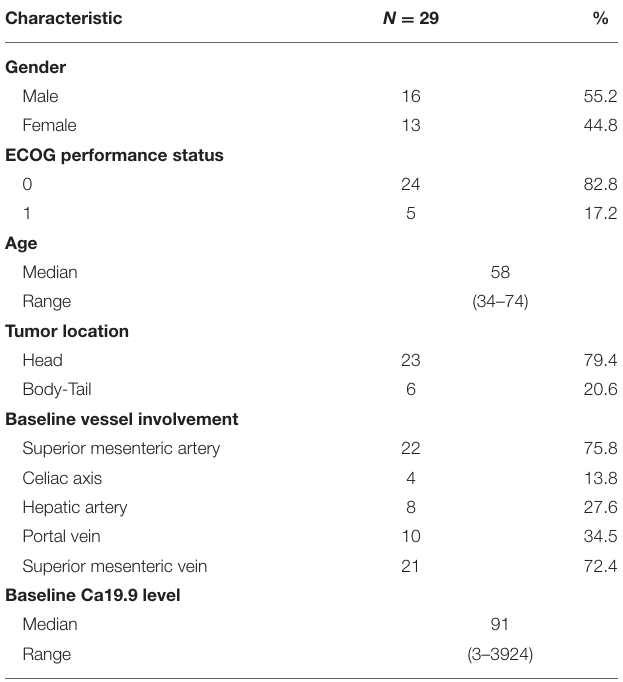
TABLE 2 | Baseline characteristics of 29 patients with PC.